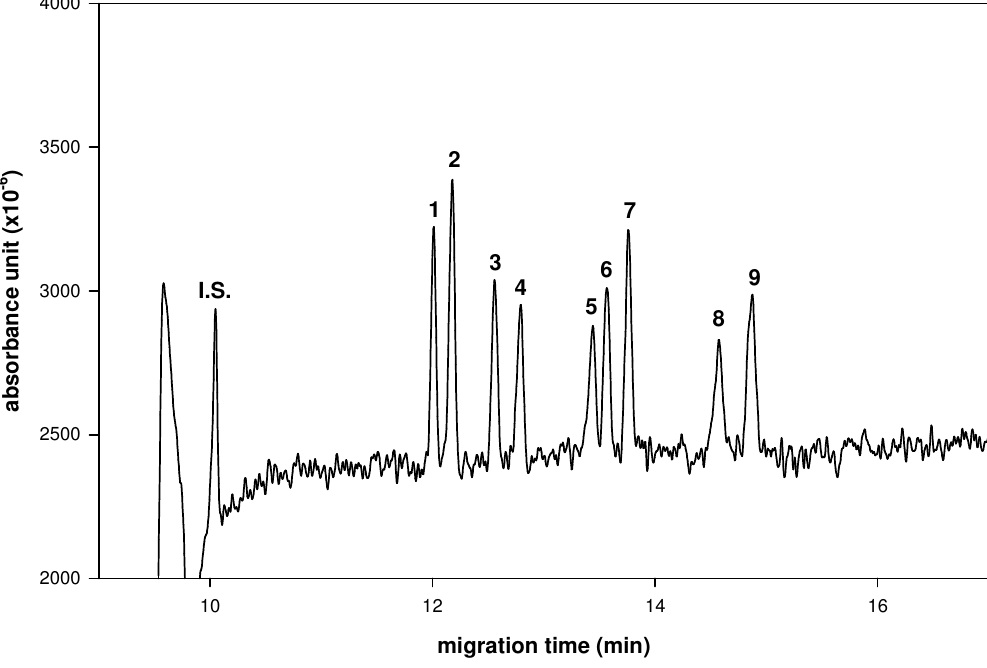
Figure 1. Electrophorogram of aldo-BINs in CE. Peaks: 1 = Rib-BIN; 2 = Rha-BIN; 3 = GlclNAc-BIN; 4 = Xyl-BIN; 5 = Glc-BIN; 6 = Man-BIN; 7 = Ara-BIN; 8 = Gal-BIN; 9 = Fuc-BIN. CE conditions: buffer, 100 mM borate (pH 9.0) contains hydroxypropyl- β -CD (10 mg/mL); applied voltage, 20 kV; uncoated fused-silica capillary, 50/60.2 cm × 50 µ m I.D.; sample injection, 3s by pressure (0.5 psi); wavelength, 254 nm; system temperature, 15